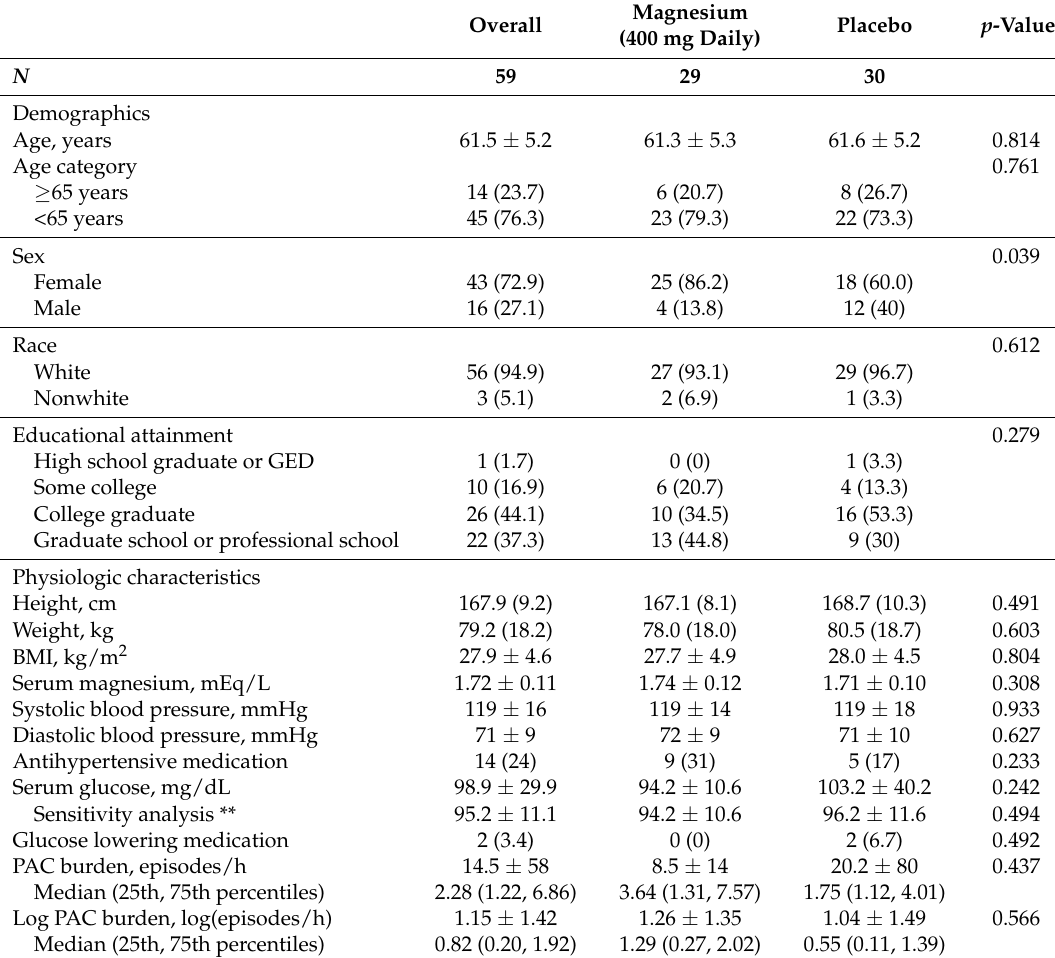
Table 1. Baseline participant characteristics * overall and stratified by intervention